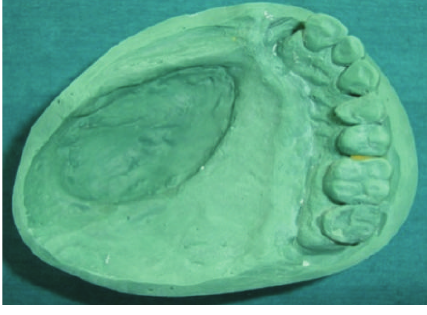
Figure 14: Master